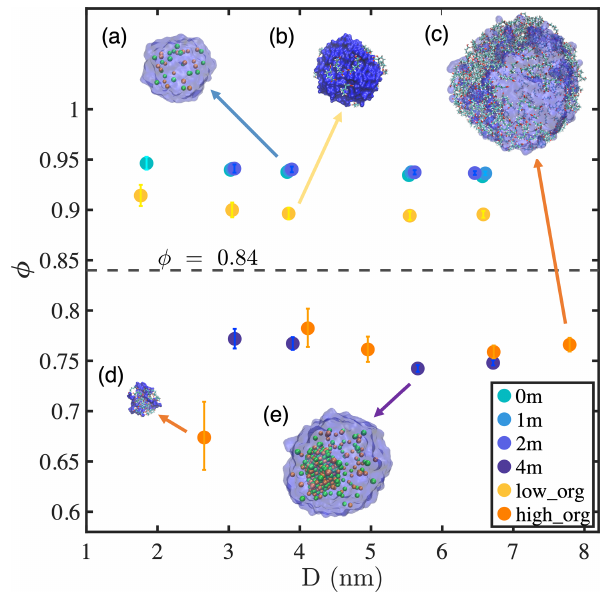
Figure 1. Sphericity factor ( φ ) of nanodroplets with different com- positions as a function of droplet diameter. Simulation snapshots are shown for the droplets with water (blue color), Na + (light- orange spheres), Cl − (green spheres), and pimelic acid (colored chains): (a) 1m NaCl with N w = 1000, (b) low PML surface load- ing with N w = 1000, (c) high PML surface loading with N w = 5000, (d) high PML surface loading with N w = 100, and (e) 4m NaCl with N w =